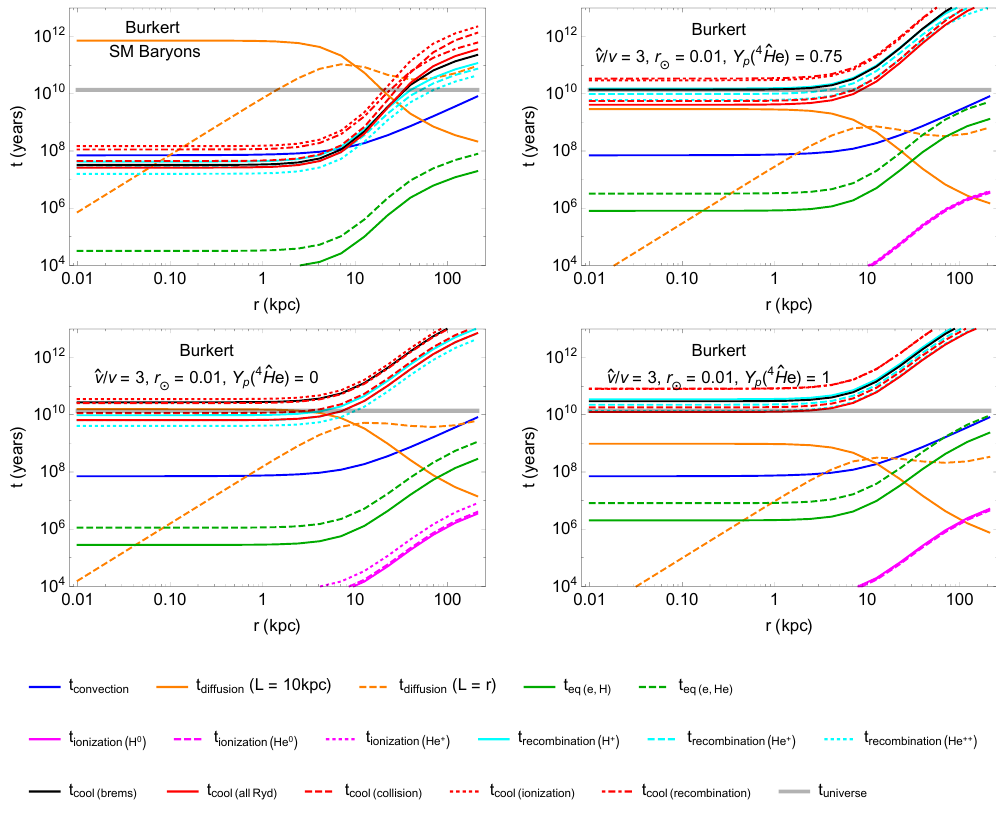
Figure 3 . Same as figure 2, but assuming the Burkert CDM